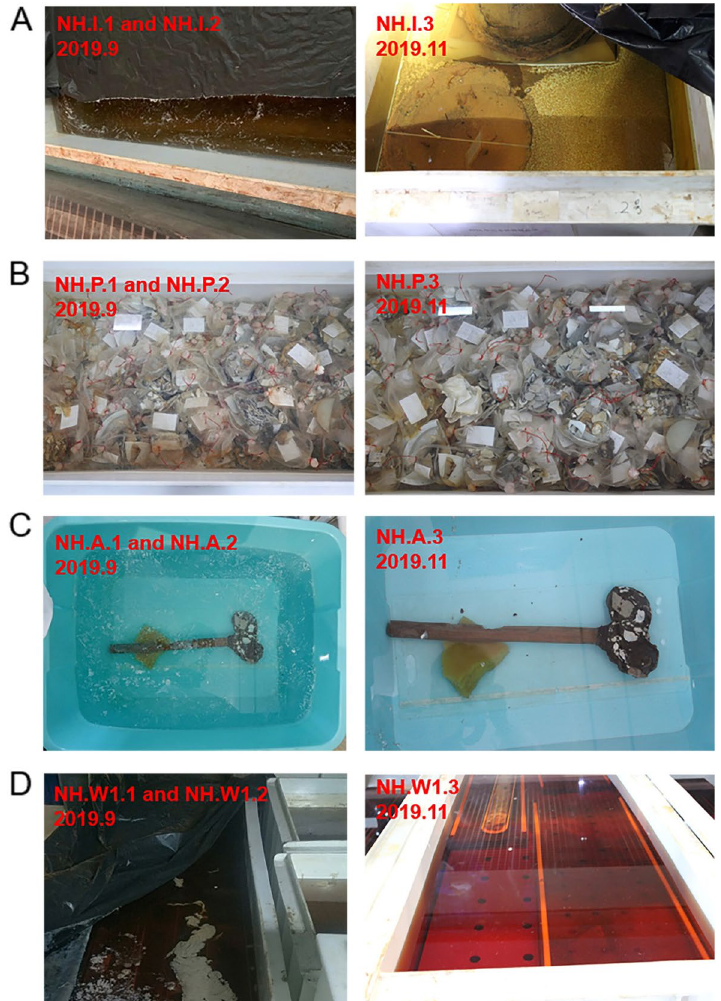
Fig. 1 Sampling pictures of four kinds of maritime cultural relic immersion water samples. Sampled in September 2019 and November 2019, respectively. A Ironware. B Porcelain. C Axe. D Hull wood